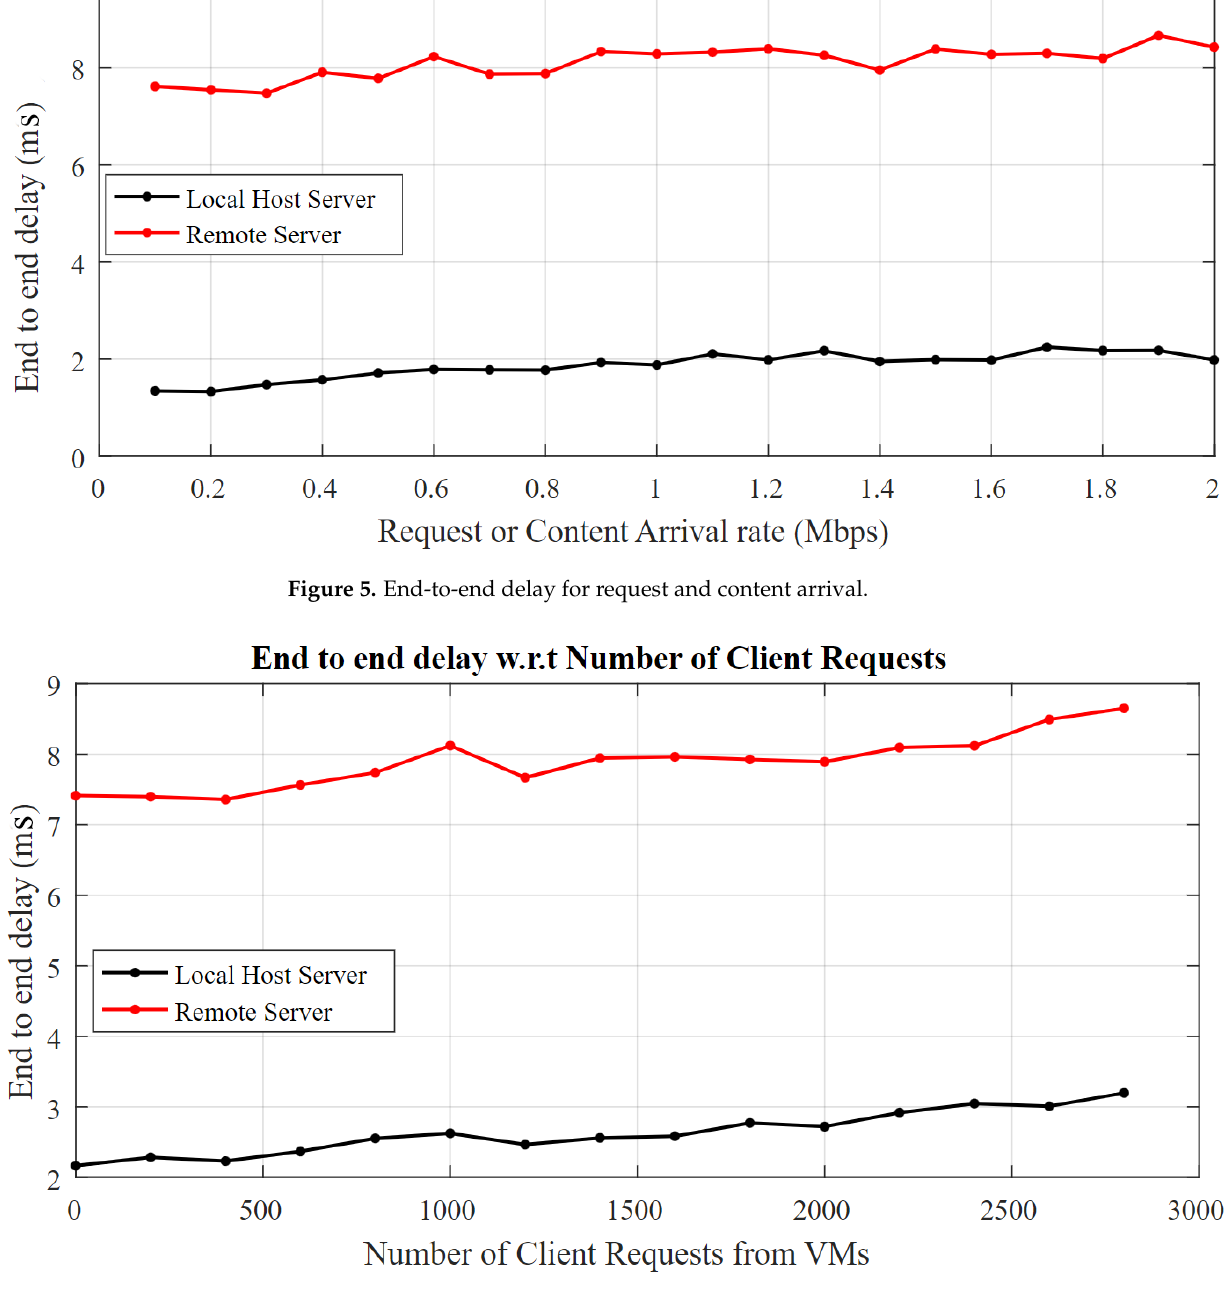
Figure 7. End-to-end delay w.r.t variation in content request time and content holding time. The analysis probability of the content delivery P Dcnt is analyzed; w.r.t content re- transmissions n and σ is given by Figures 8 and 9. Both figures can be directly used as a benchmark for the scalability of smart cities’ services. The request duration is incremented from 1 µs to 20 µs with a 4 – 5 µs step, likewise. It is worth noting that P Dcnt linearly